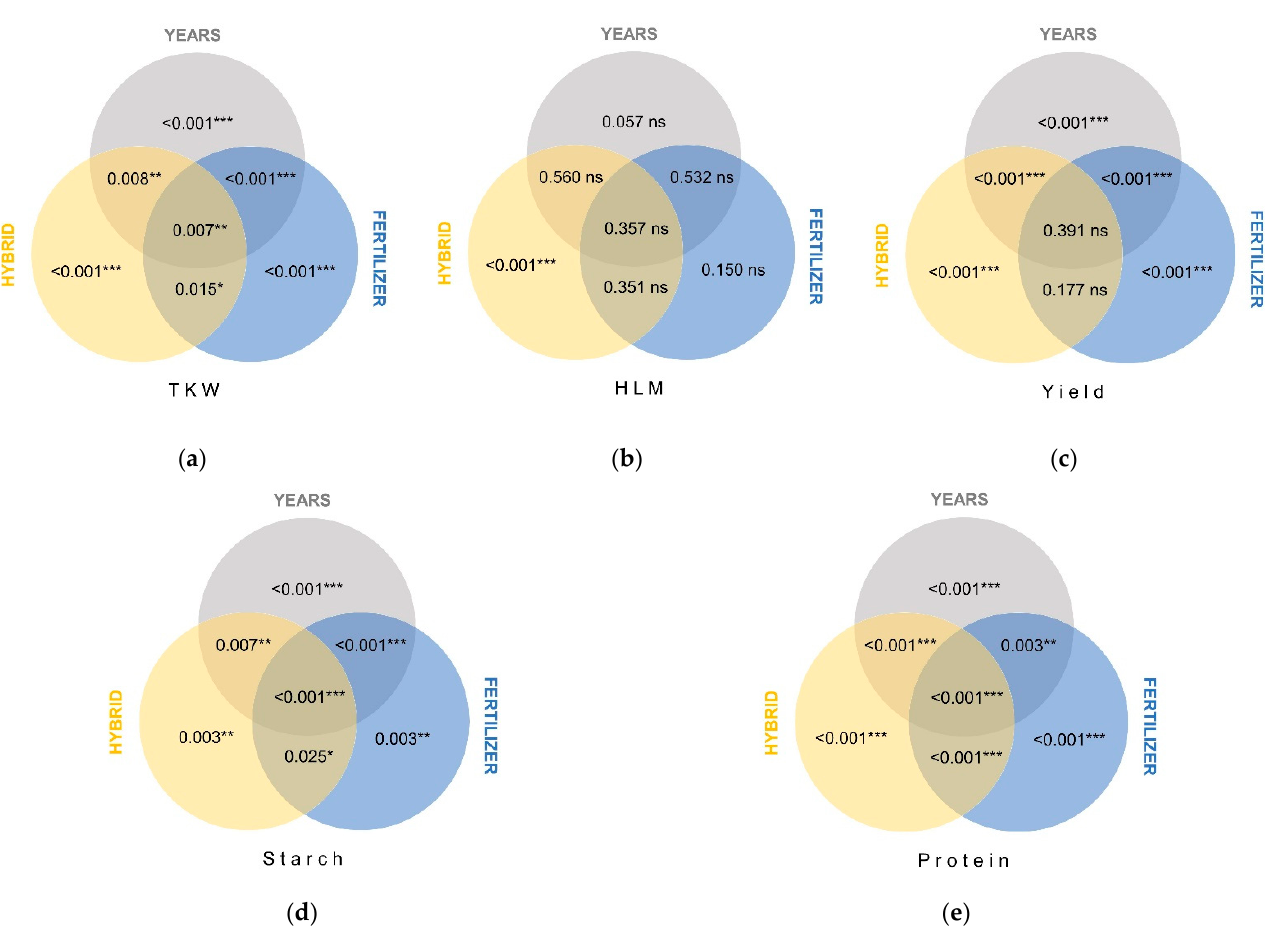
Figure 4. Venn diagram depicting the influence of experimental factors and their interaction on maize quantitative productivity components: ( a ) thousand kernels weight; ( b ) hectoliter mass; ( c ) yield; ( d ) starch content; ( e ) protein content. Numbers represent p -values according to three-way ANOVA results; significance levels assigned p > 0.05 (ns), p < 0.05 (*), p < 0.01 (**), p < 0.001 (***).